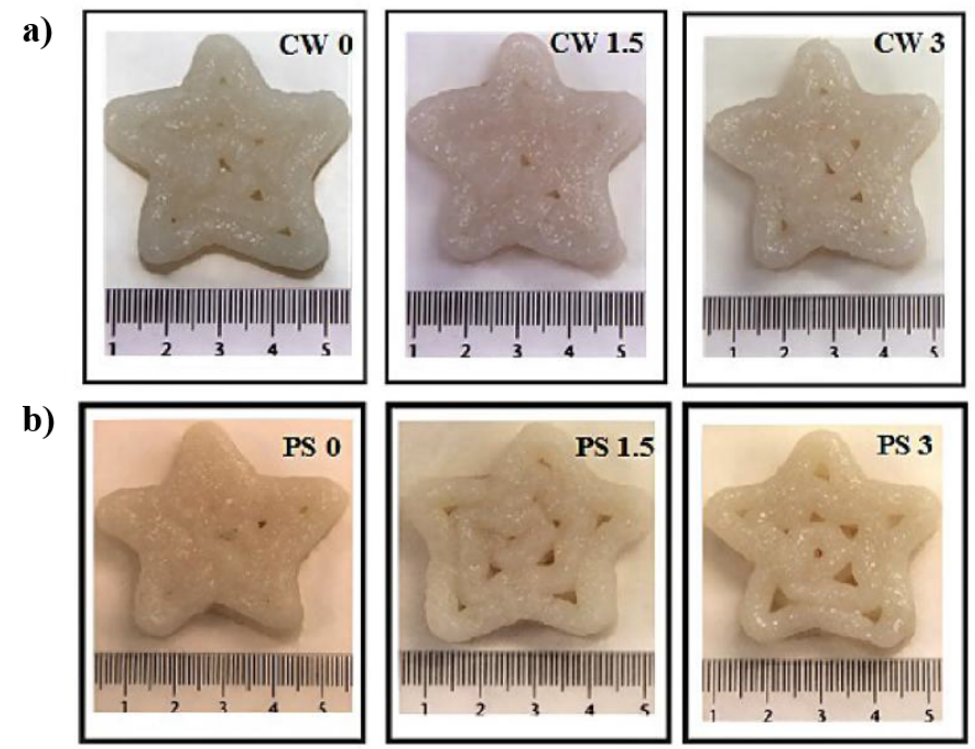
Figure 7. 3D-printed surimi from cod by-products ( a ) conventionally washed and ( b ) pH-shift processed with the addition of 0, 1.5, and 3.0% salt “Reprinted/adapted with permission from Ref. [64]. Copyright © 2019, John Wiley &